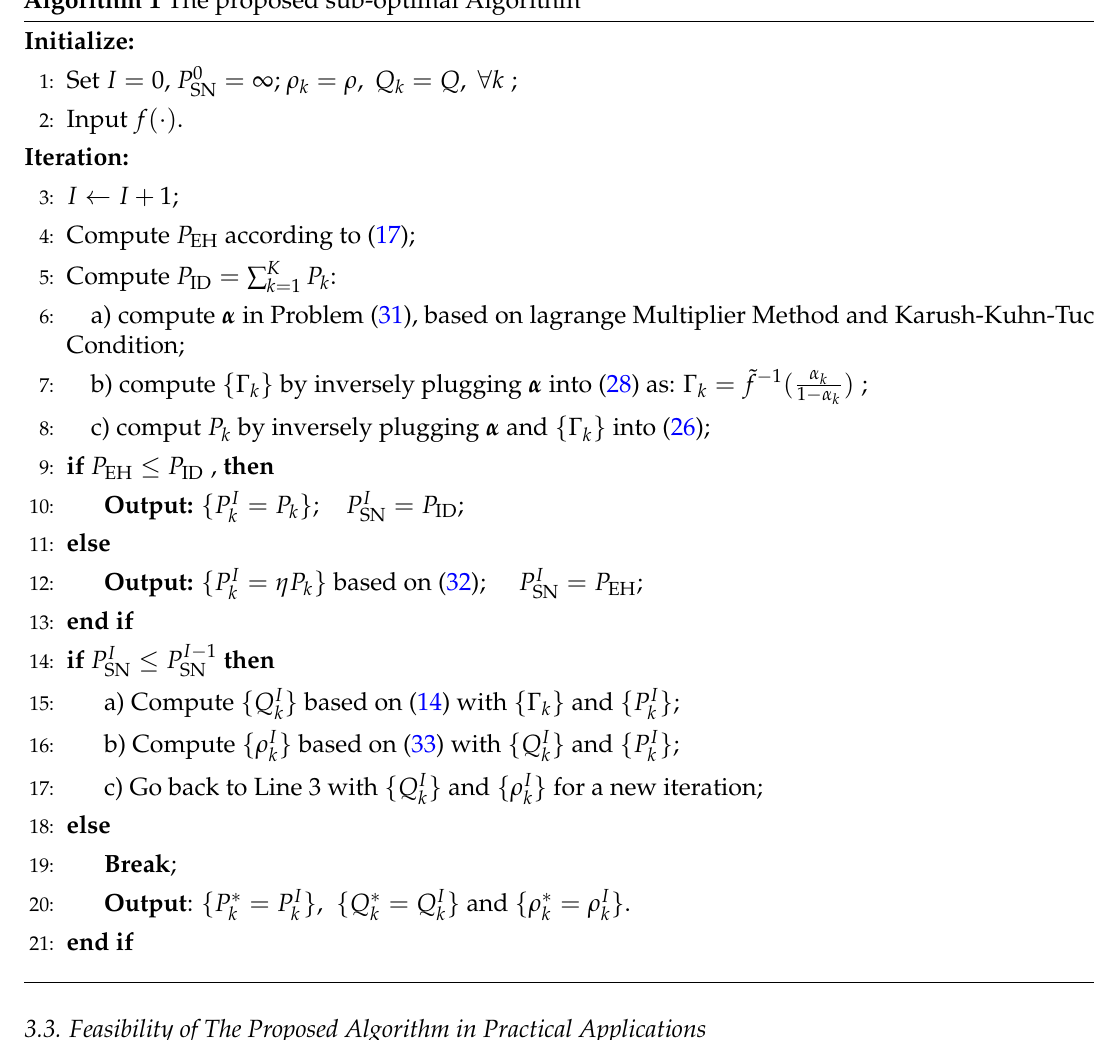
Algorithm 1 The proposed sub-optimal